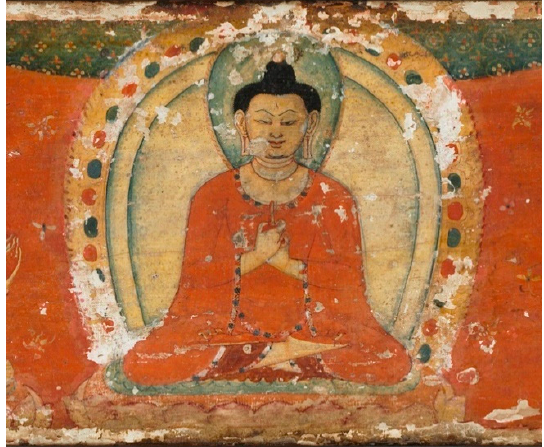
Figure 12. Vairocana, detail of top cover. Perfection of Wisdom in Eight Thousand Lines: A ṣṭ as ā hasrik ā Prajñ ā p ā ramit ā -s ū tra , 1119. Nepal. Gum tempera on wood. H: 6.5 cm. Cleveland Museum of Art, purchase from the J. H. Wade Fund, 1938.301.1.